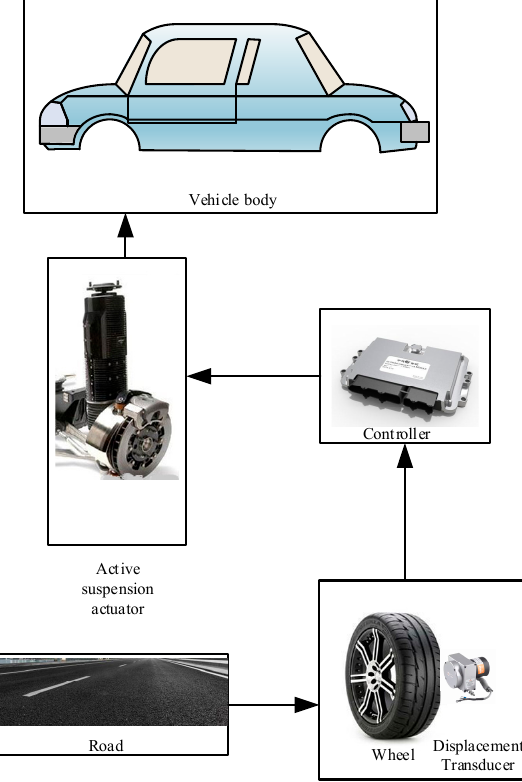
Figure 1. Structure and control principle of the active suspension system.